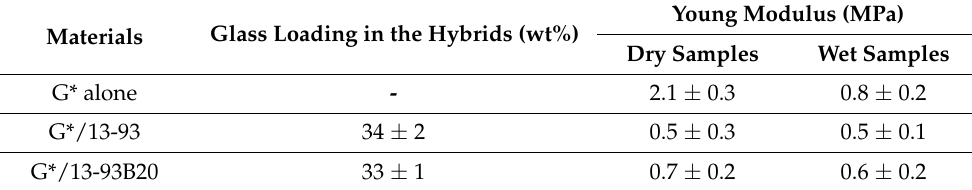
Table 2. Measured glass loading and Young’s modulus of the gelatin alone functionalized (G*) and the G*/13-93 and G*/13-93B20 hybrids (for wet samples, the mechanical properties were measured after 10 min of immersion in TRIS). Materials Glass Loading in the Hybrids